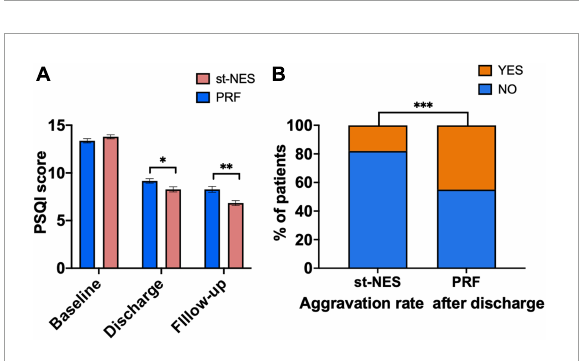
prolonged bleeding, hematoma formation, spinal cord injury, etc.) were found in the two groups.